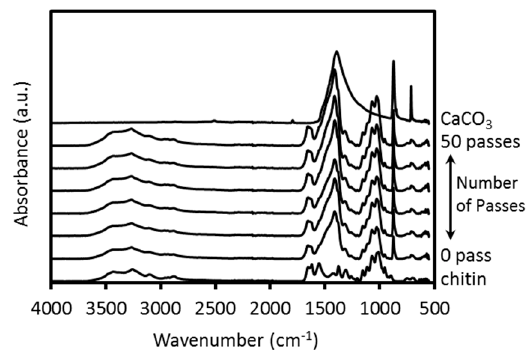
Figure 2. FTIR-ATR spectra of pure chitin, calcium carbonate, and crab shells treated with 0, 1, 5, 10, 30, and 50 passes through a high pressure water jet system.